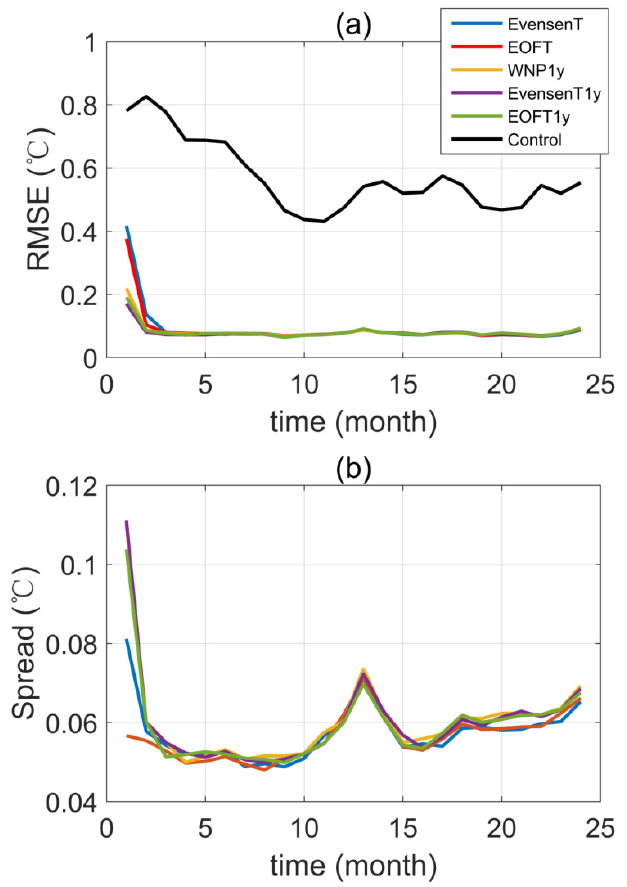
Figure 7. Time series of RMSE ( a ) and spread ( b ) of the SST compared with the true data for the six Figure 7 . Time series of RMSE (a) and spread (b) of the SST compared with the true data for the six experiments in region (70 ◦ S~70 ◦ N, 180 ◦ E~180 ◦ W) for a two-year experiments in region (70° S ~ 70° N, 180° E~180° W) for a two-year period.